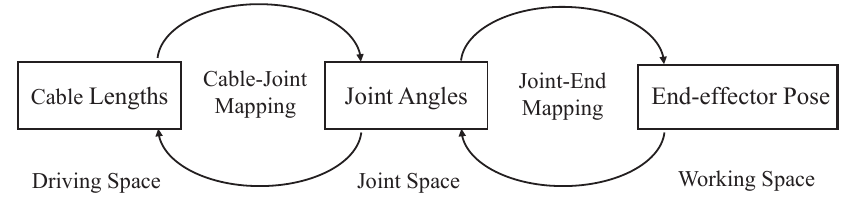
Figure 2. Multilevel mapping relationships of the manipulator.